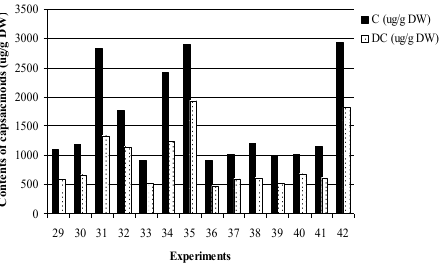
EtOH/H O as a solvent. 2